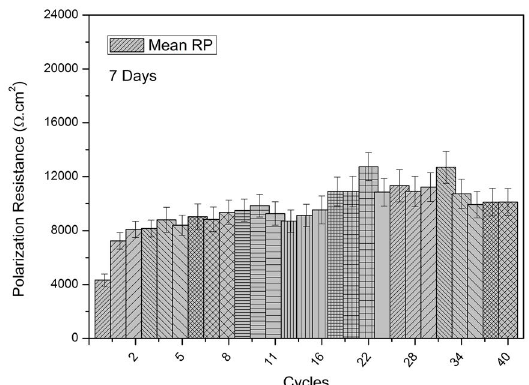
for 3, 7 and 28-day P